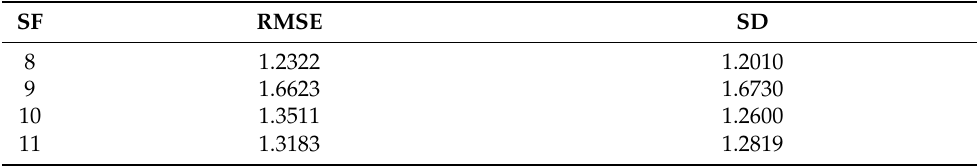
Table 2. Downlink Neural Network